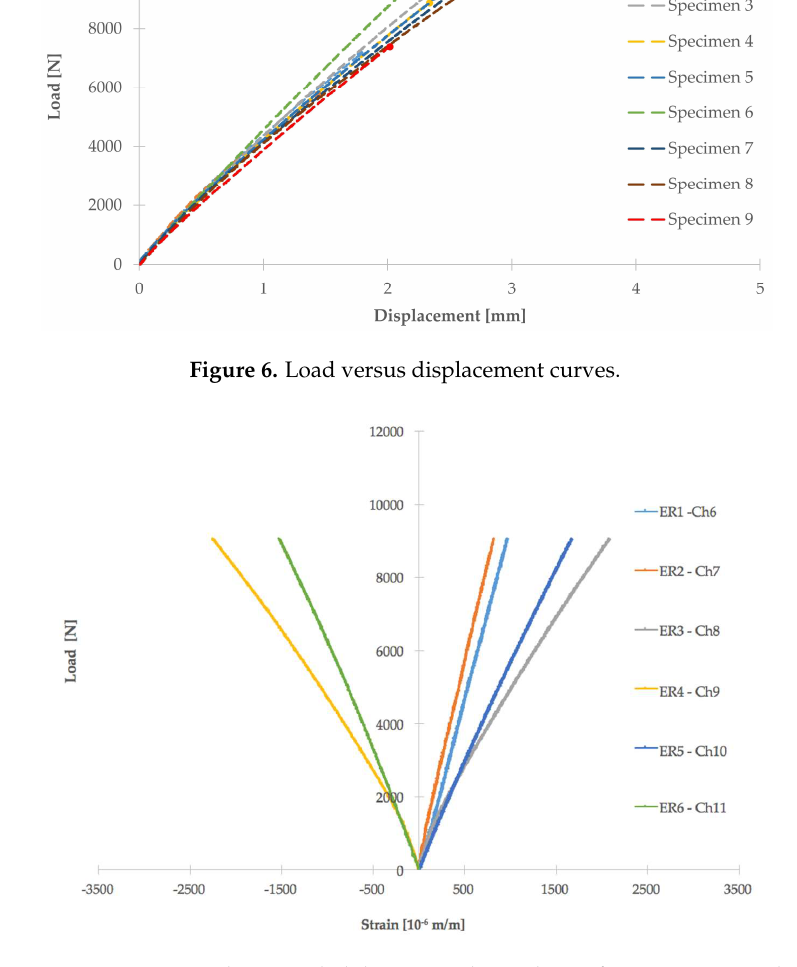
Figure 7. Strain gages value recorded during mechanical tests for specimen number 3.